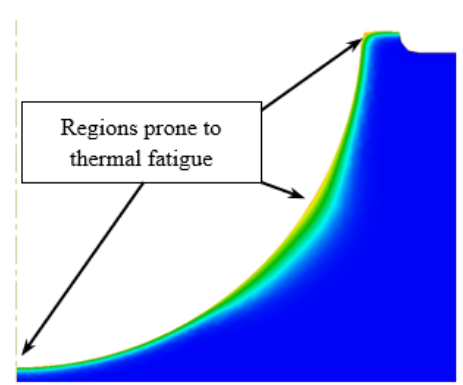
Figure 5. Regions in the lower die prone to thermal fatigue according to the numerical